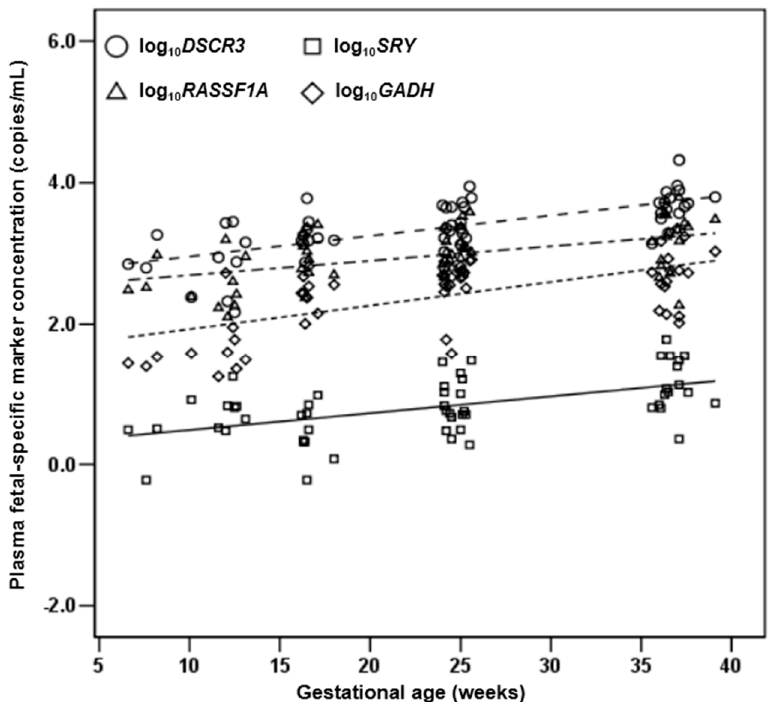
Figure 3. Relationship between concentrations of all markers and gestational age in the control group. The mean value for DSCR3 is shown as dashes; for RASSF1A as dash-dots; for SRY as solid; for GAPDH as dots. The Y axis represents a logarithmic scale.